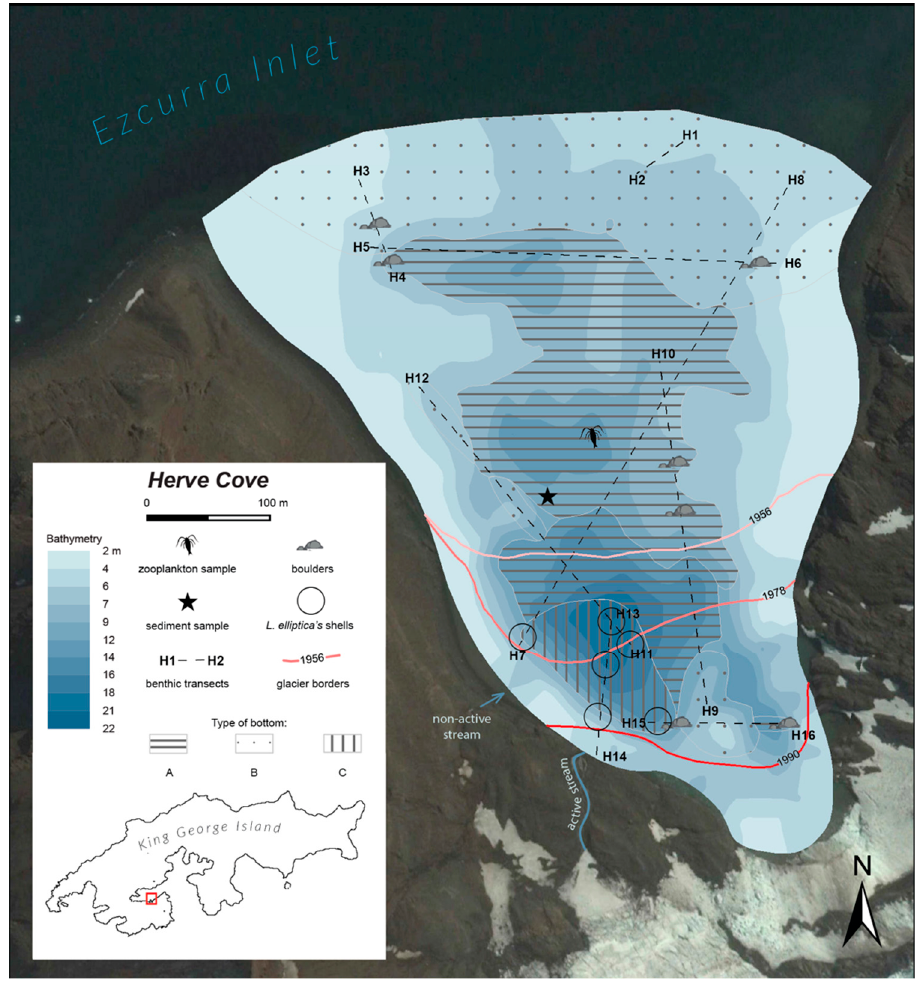
Figure 1. Study area, Herve Cove in Admiralty Bay, with glacier borders since 1956, the photo-transects along which the benthic communities surveys were made, and the plankton sampling station. Types of bottom recognized in the study area (A. soft bottom - sandy, silty and clay deposits, B. hard bottom - rocky and rocky-sandy deposits, C. soft bottom in the vicinity of streams), with boulders (B1) on soft bottom, bathymetry of the cove, and locations of empty shells of Laternula elliptica in the vicinity of glacier streams.